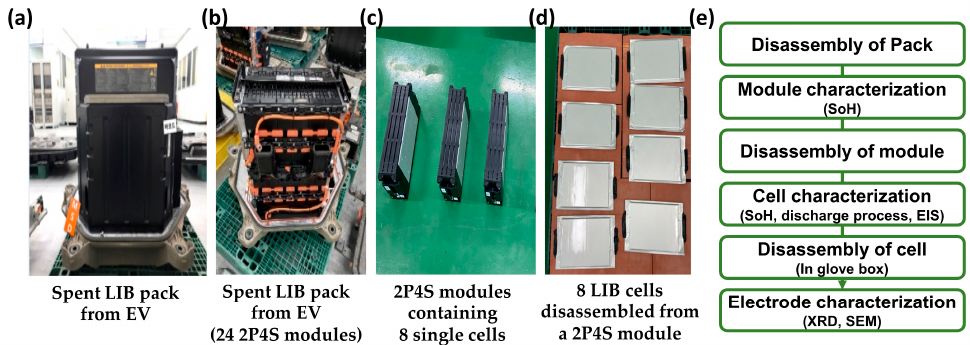
Figure 2. Photographic images of ( a ) the spent LIB packs from the EV, ( b ) 24 2P4S modules in the LIB pack, ( c ) 2P4S modules, ( d ) single LIB cells disassembled from a 2P4S module, and ( e ) experi- mental